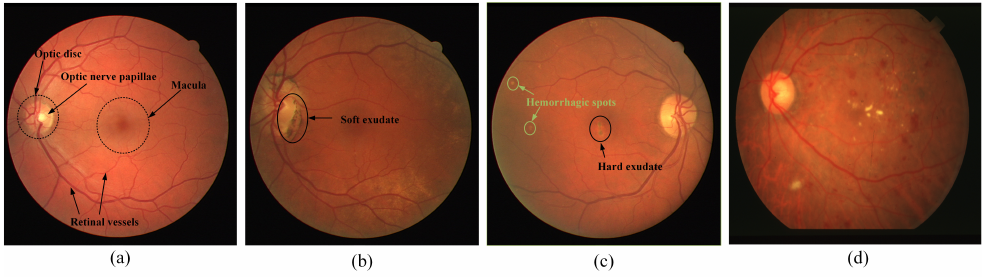
Figure 1. Retinal fundus images. ( a ) normal fundus image; ( b ) background diabetic retinopathy, pigment epithelial atrophy; ( c ) choroidal lesion; ( d ) narrowing, entire venous